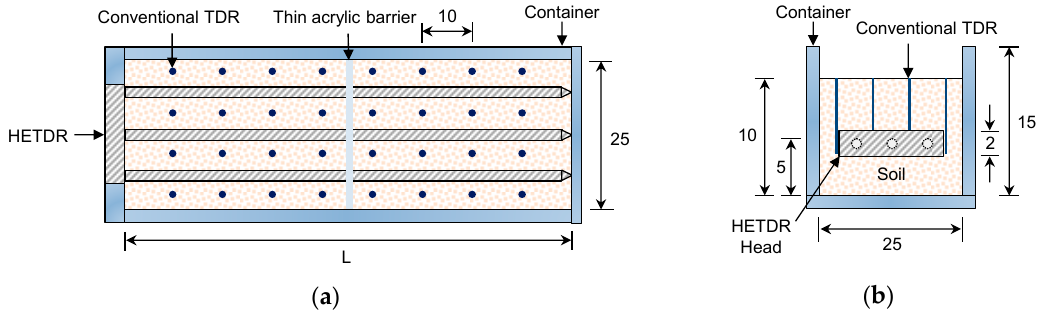
Figure 2. HETDR probe with a container: ( a ) plan view; ( b ) side view. All values are expressed in cm. TDR: time domain reflectometry.